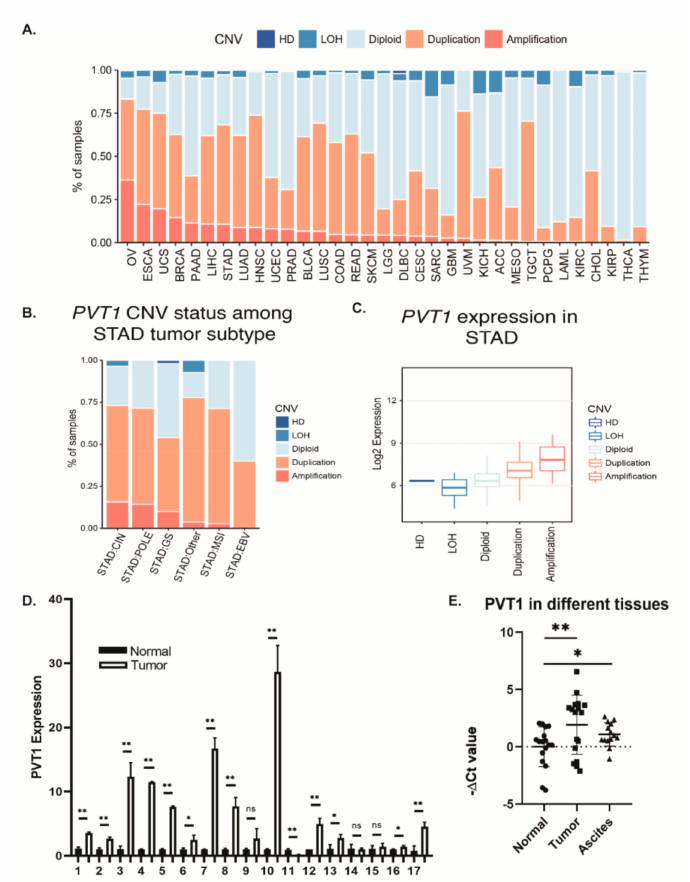
Figure 1. LncRNA PVT1 is amplified and overexpressed in GAC tissues compared to in normal tissues. ( A ) Analysis of PVT1 genomic alteration in the TCGA dataset revealed that PVT1 was amplified in over 15% of STAD (GAC) cases; around 70% of STAD cases contained both amplification and duplication. ( B ) Amplification of PVT1 gene in the CIN subtype was more common than in other subtypes. ( C )